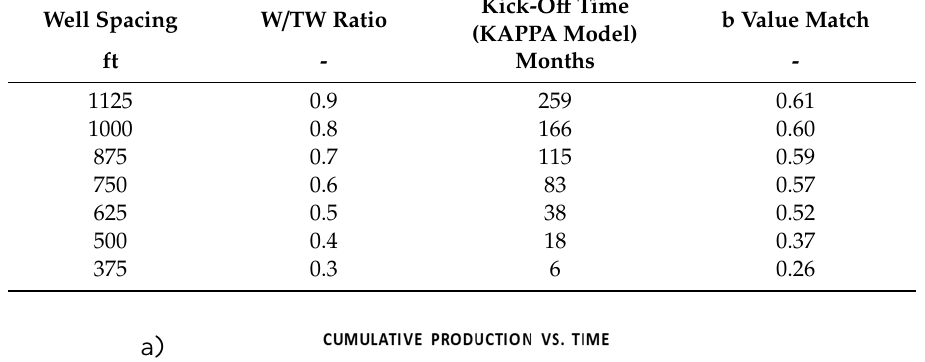
Table 4. History matched b values for given KAPPA model kick-o ff times with decreasing well spacing.